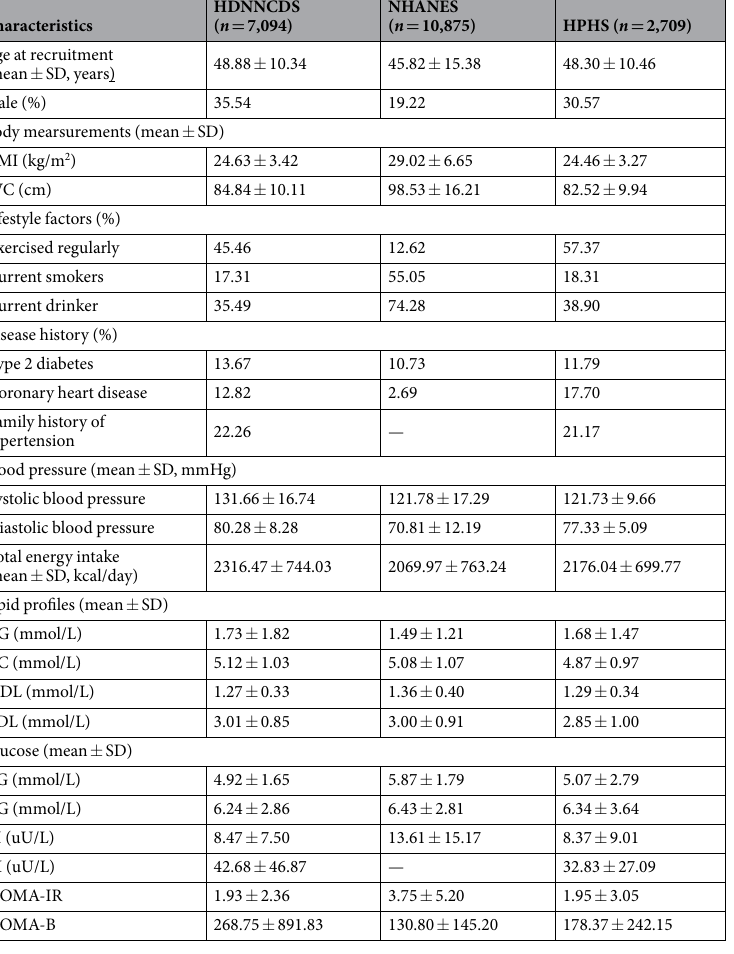
Table 1. Descriptive characteristics of participants at baseline in the Harbin Cohort Study on Diet, Nutrition and Chronic Non-Communicable Diseases (HDNNCDS, 2012), the US National Health and Nutrition Examination Survey (NHANES), and the Harbin People’s Health Study (HPHS, 2008–2012). Abbreviation: SD, standard deviation; BMI, body mass index; WC, waist circumference; TG, triglyceride; TC, total cholesterol; HDL, high density lipoprotein; LDL, low density lipoprotein; FG, fasting glucose; PG, 2-h postprandial glucose; FI, fasting insulin; PI, 2-h postprandial